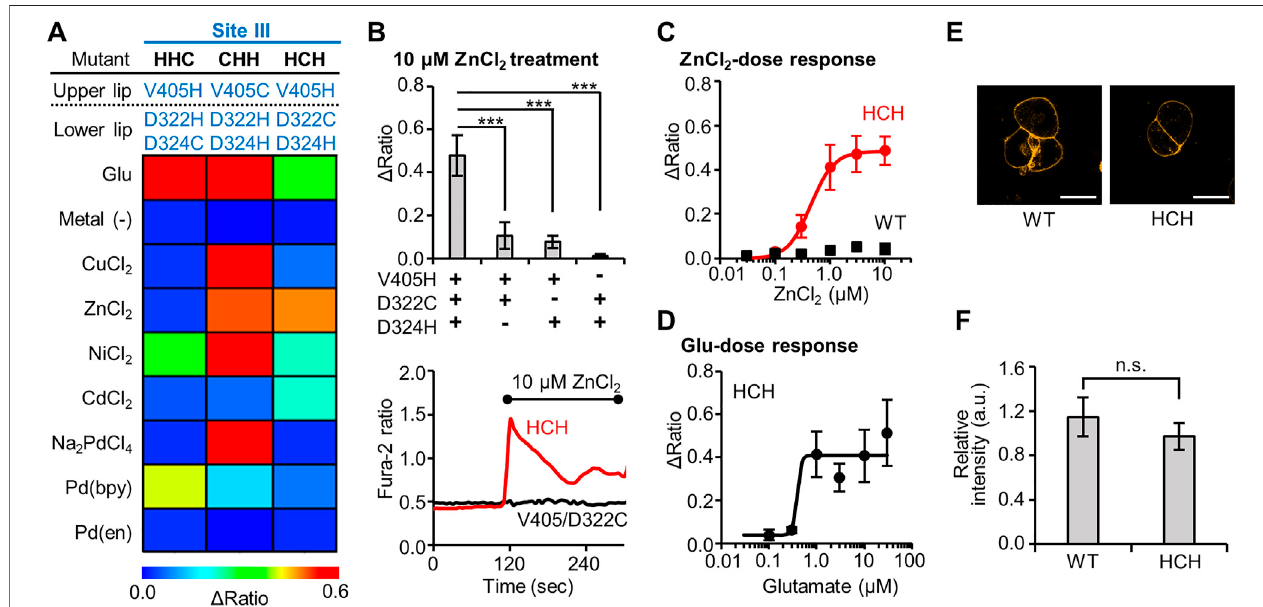
FIGURE3 | Identi fi cation ofZn 2+ -responsivemGlu1 mutant and its characterization. (A) Heat map ofthe secondary screening. Themap shows the average Δ ratio values upon the addition of 10 μ M glutamate or 3 μ M metal ion or complex. See Supplementary Figure S5 for raw data. (B) Mutation study to con fi rm the Zn 2+ - coordination at the mutation sites. Upper ; The Δ ratio values for the HCH, V405H/D322C, V405H/D324H, and D322C/D324H mutants. Lower ; representative traces of the cells from two mutants. The black bar shows the period when ZnCl 2 was added. (n (cid:1) 12 – 20). (C) Activation of WT mGlu1 (black) or the HCH mutant (red) by Zn 2+ . The EC 50 value for the mutant was 0.44 μ M. (n (cid:1) 11 – 20). (D) Activation of the HCH mutant by glutamate (Glu). The EC 50 value of the mutant was 0.39 μ M. (n (cid:1) 11 – 20). (E) Evaluation of the expression and distribution ofmGlu1 mutant on the cell surface using FITM-Cy3. The representative confocal images are shown. The scale bar shows 20 μ m. (n (cid:1) 50 – 70). (F) Quanti fi cation of signal intensity from FITM-Cy3. Data are presented as mean ± s.e.m. ***Signi fi cant difference ( p < 0.001, One-way ANOVA with Dunnet ’ s test). n.s, not signi fi cant ( p > 0.05, Student ’ s t